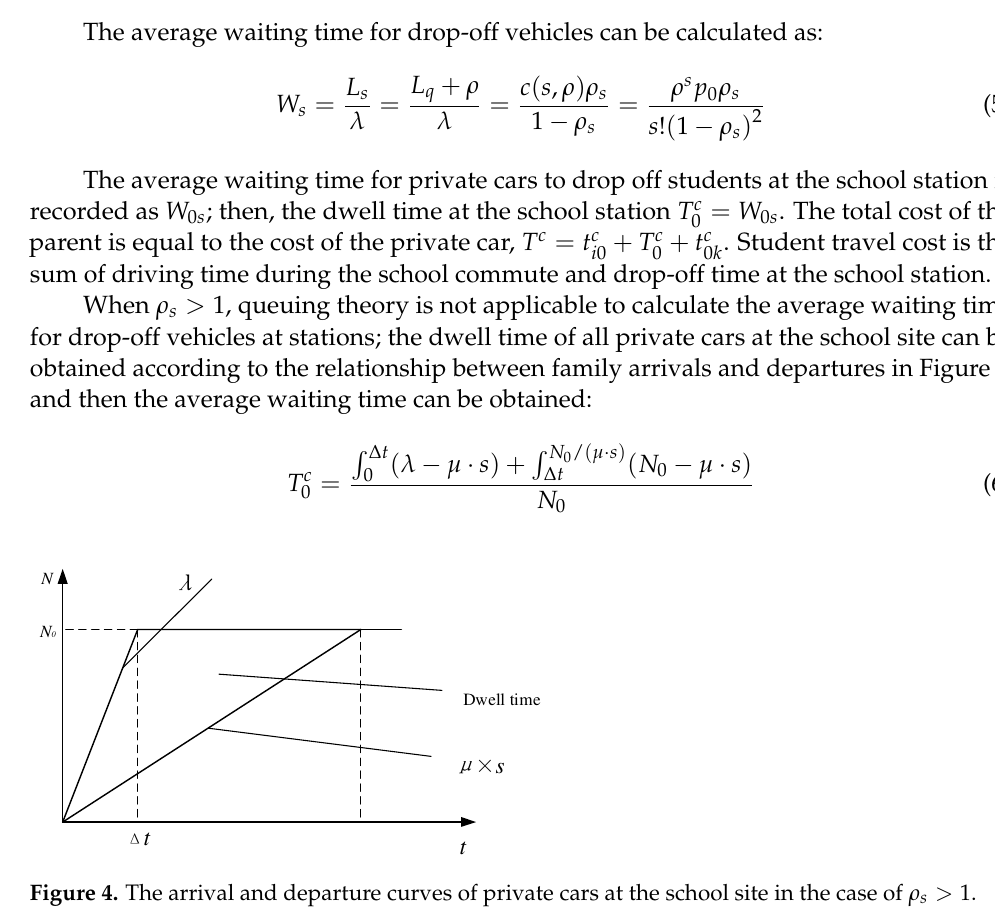
Figure 4. The arrival and departure curves of private cars at the school site in the case of 1